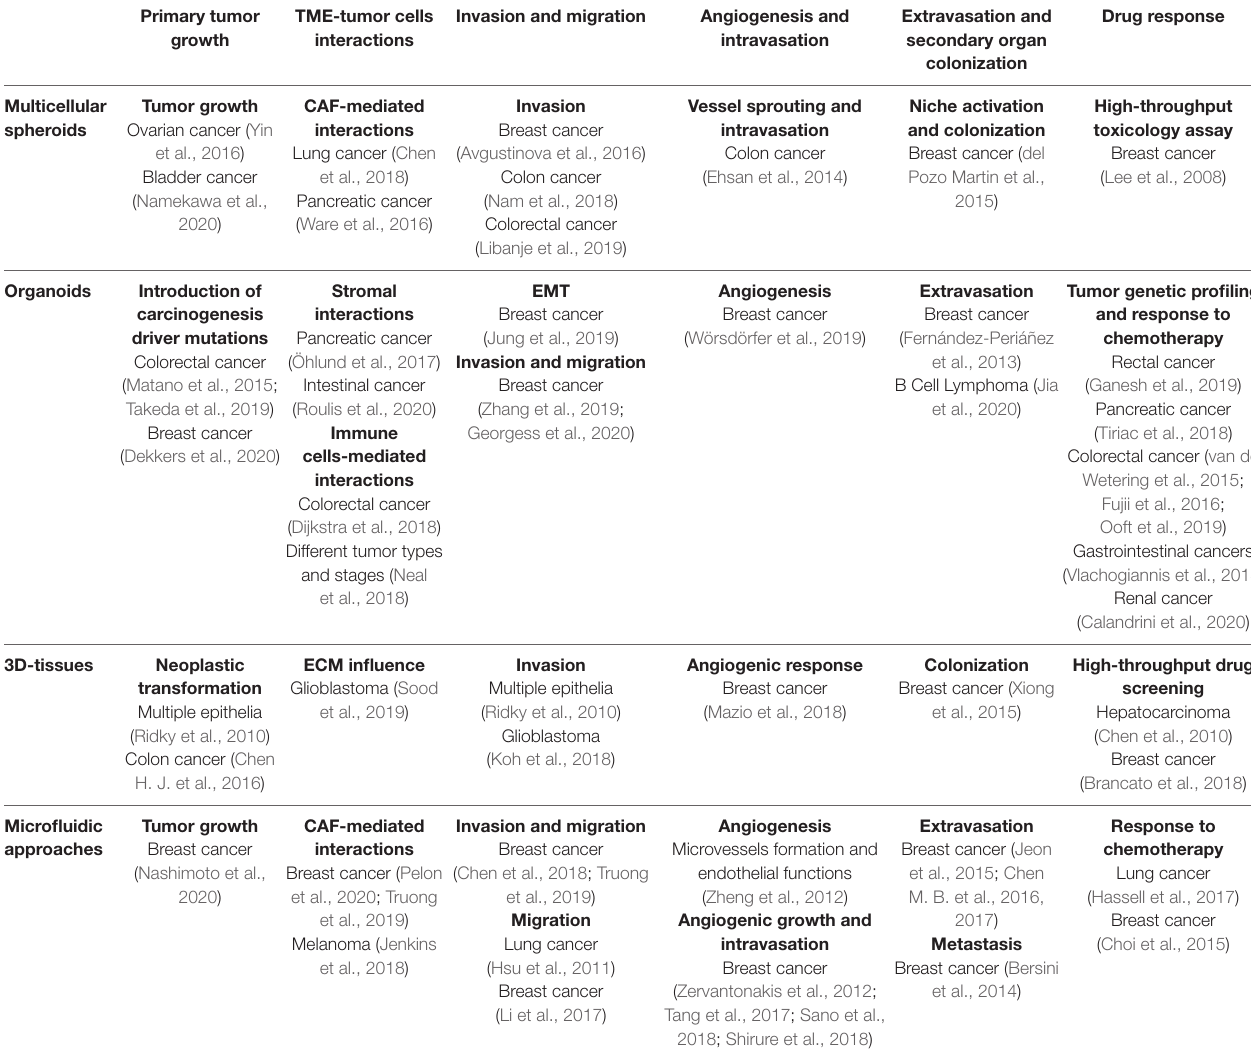
TABLE 1 | Organotypic models used to study cancer progression stages and drug